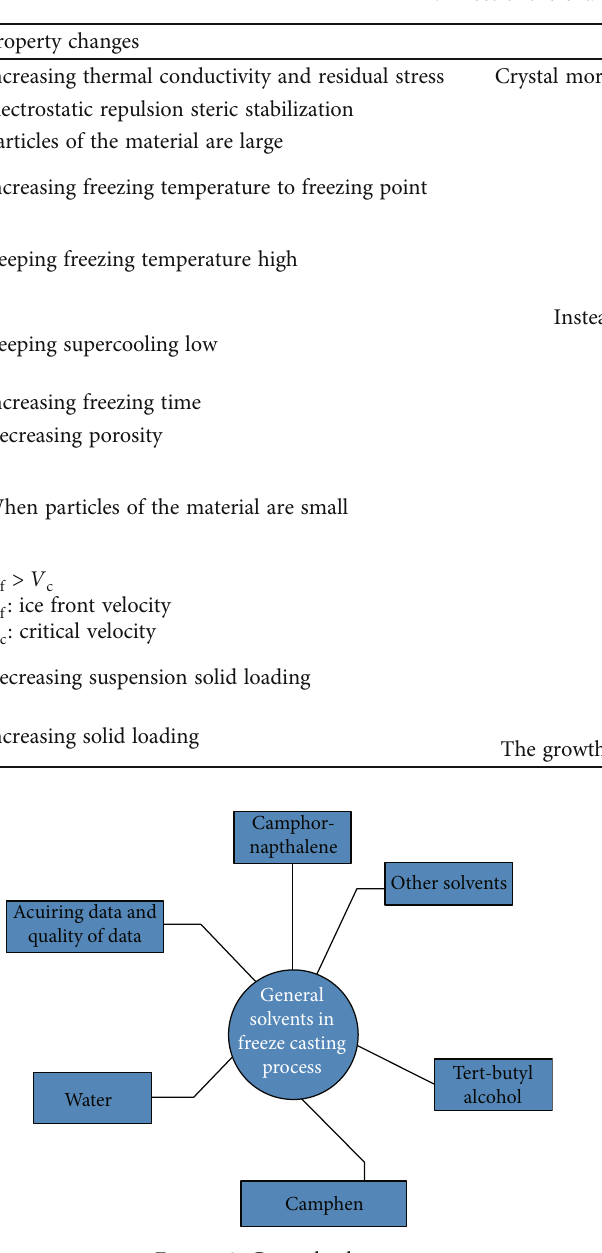
Table 1: E ff ect of the change on the porous material.